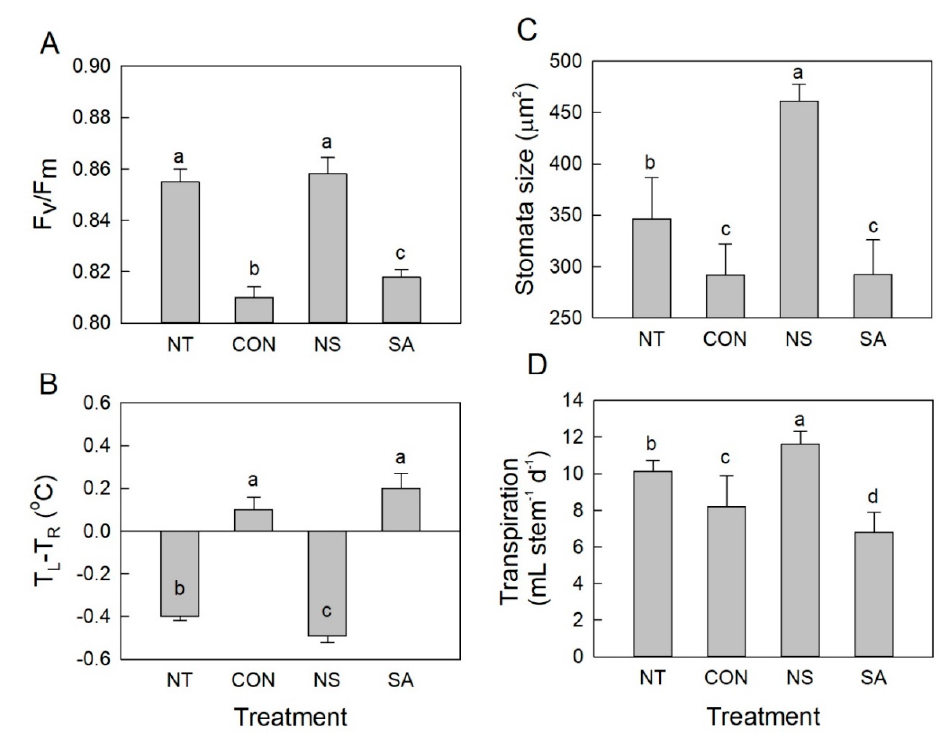
Figure 4. Effect of B. cinerea infection on maximum quantum yield of PSII (F v /F m ) ( A ), leaf temperature ( B ), stomata size ( C ), and transpiration ( D ) of cut roses on day 1 after the transport simulation. NT, non-treated flowers; CON, flowers were held in distilled water; NS and SA, cut flowers were treated with nano silver and salicylic acid. Leaf stomatal size and transpiration of cut flowers were measured on day 1 of vase life. CON, NS, and SA flowers were sprayed with B. cinerea conidial suspension to induce gray mold development. All flowers were then stored at 10 ± 2 °C and 80–90% RH in dark conditions for 4 d for export simulation. Different letters above bars indicate statistically significant differences among treatments at p = 0.05 based on Duncan’s multiple range test. Vertical bars show standard errors of the means ( n = 3 for ( A – C ) and 9 for ( D )).